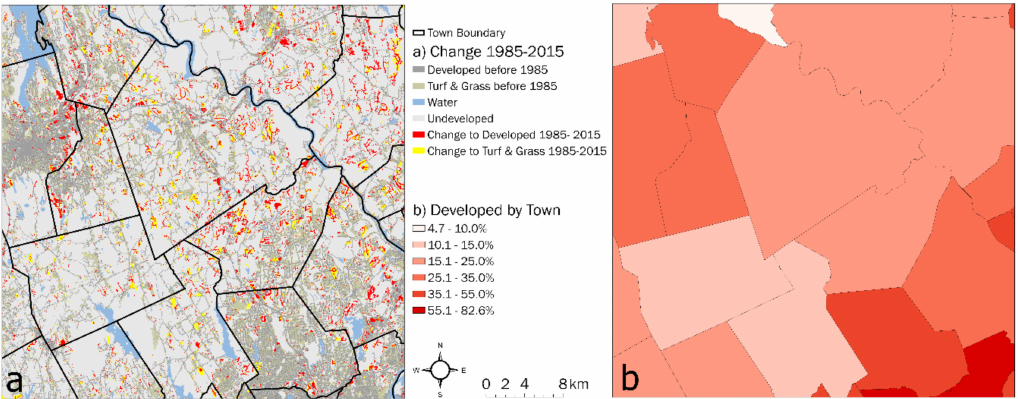
Figure 2. Examples of change maps for the same region shown in Figure 1. ( a ) Map showing areas converted to developed (red) or turf and grass (yellow) categories during the 1985–2015 period. ( b ) Map showing percent of developed category, by town (darker red indicates higher